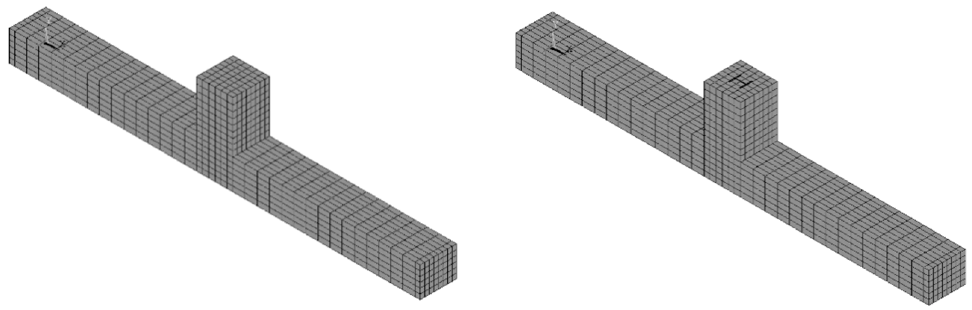
Figure 4. Prototypes P03, P04, and P05 (similar to P03 with different reinforcements), simulated with ANSYS.